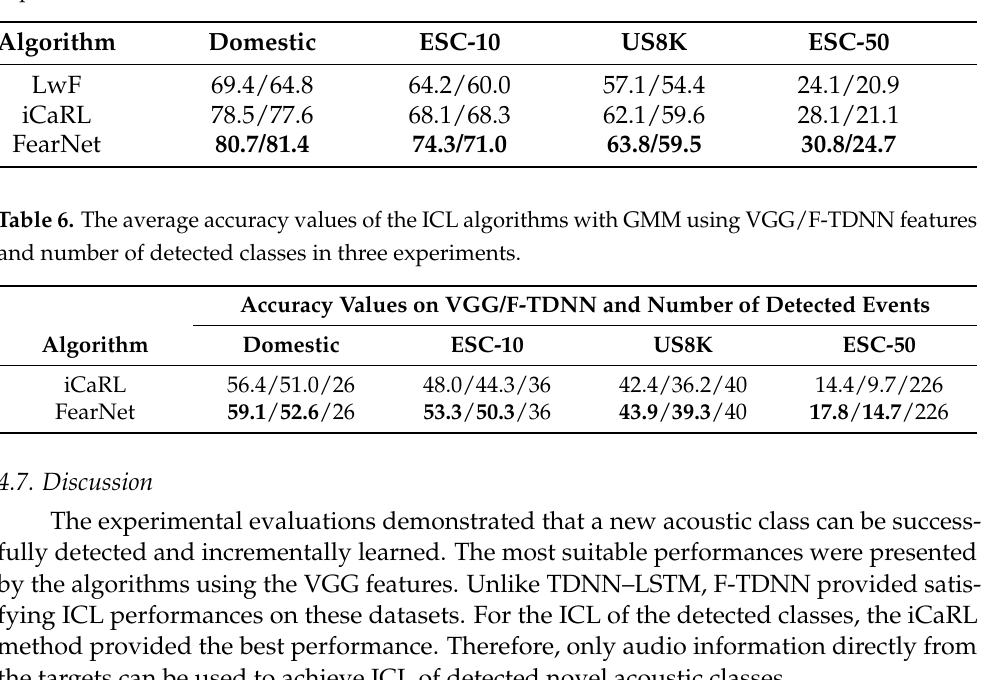
Figure 7. The performances of FearNet and iCaRL with GMM on ESC-50 in which the deep features, VGG, and F-TDNN of new classes detected by GMM are incrementally learned. Table 5. The average accuracy values of the ICL algorithms using VGG/F-TDNN features in five experiments.